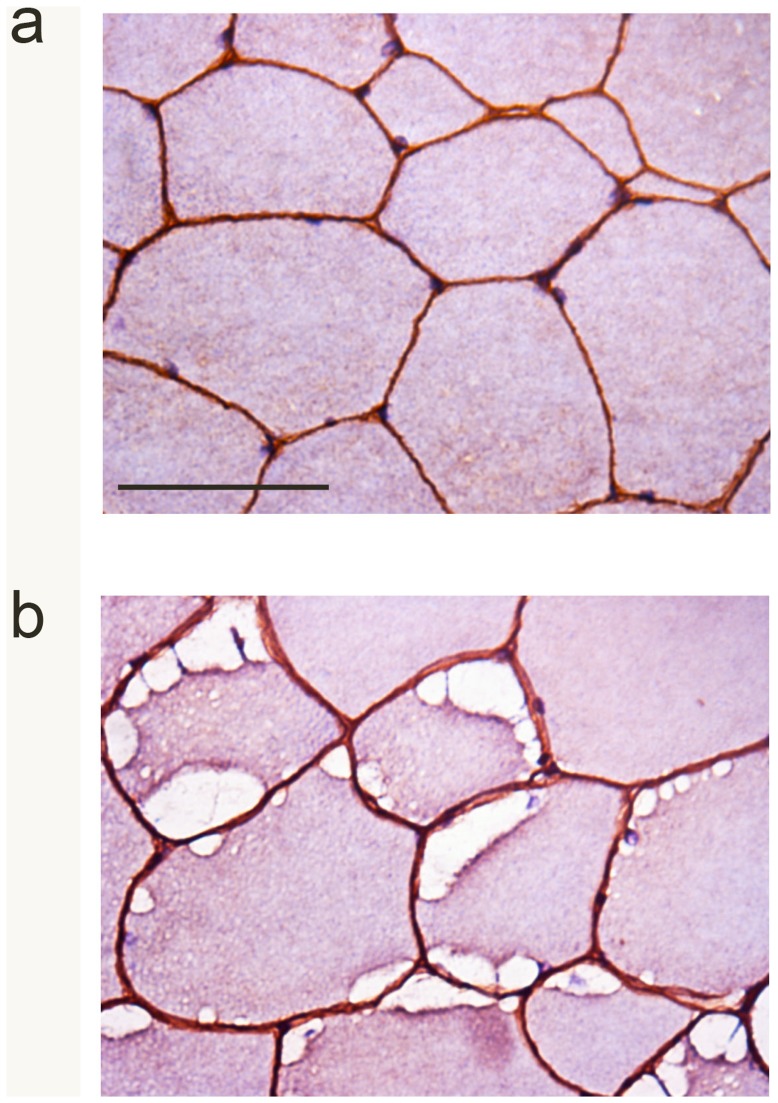
Dystrophin localisation.Representative images of dystrophin immunohistochemistry (brown staining) in skeletal muscle counterstained with haematoxylin and eosin from (A) a control horse and (B) a horse heterozygous for the GYS1 mutation. Note the normal dystrophin expression and localisation in the region of the subsarcolemmal vacuoles (arrows). Bar = 50 µm.